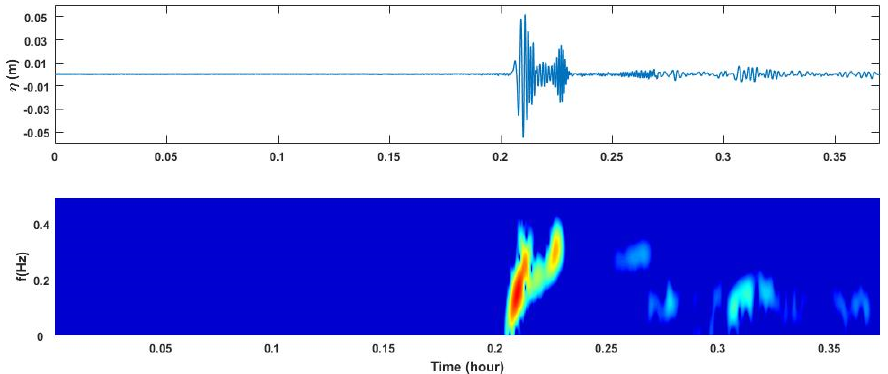
Figure 5. Modeled water surface elevation time series (top panel) and spectrogram (bottom panel) of wakes generated by the Pink Lady vessel at the CP measurement location.